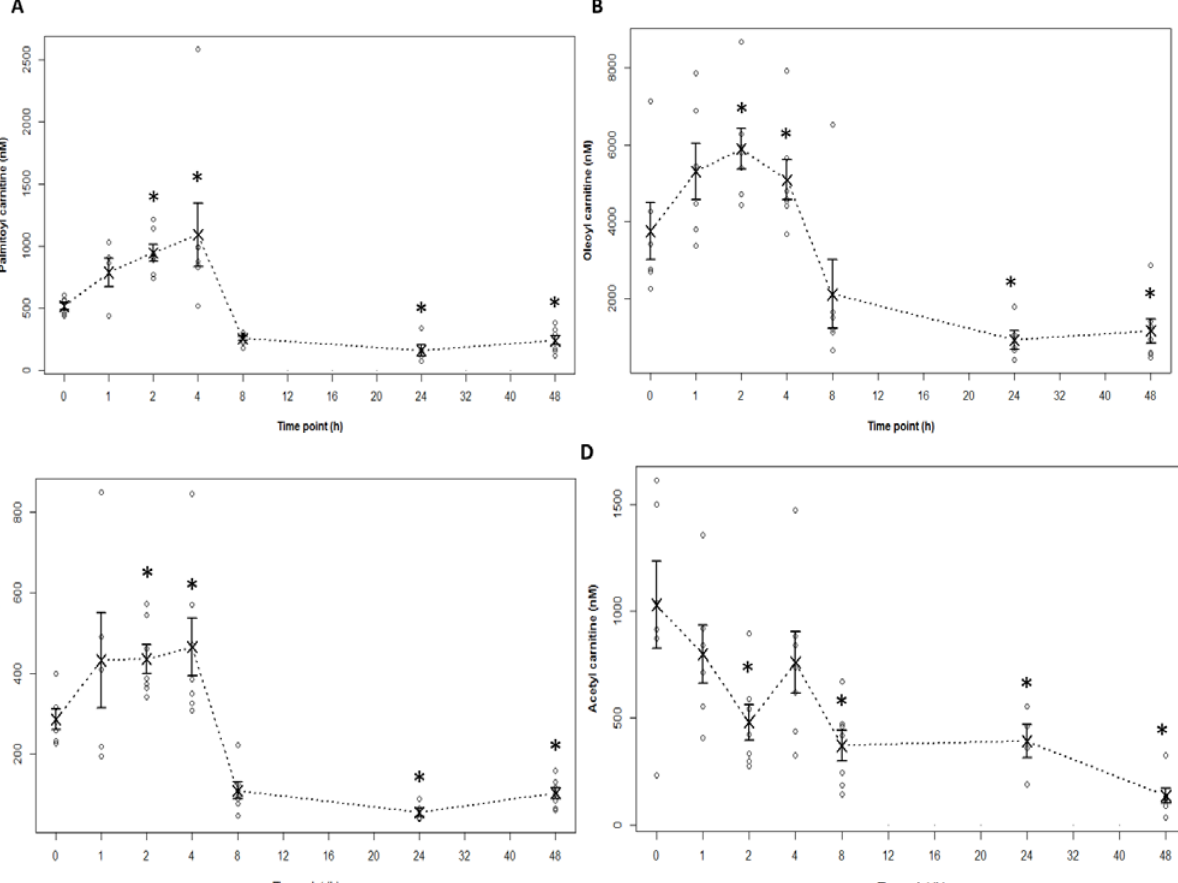
Figure 5. Serum acylcarnitine levels in mice treated with saline or APAP 200 mg/kg. The long chain acylcarnitines, palmitoyl ( A ), oleoyl ( B ) and myristoyl carnitine ( C )